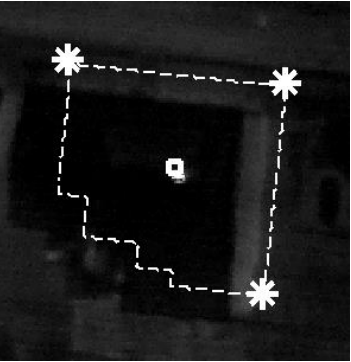
Fig. 3. Building polygon from OSM data shown by dashed line. Potential GCPs formed by significant lines of the polygon are shown by a white star, polygon centroid is shown by a white square. Background layer – thermal image.